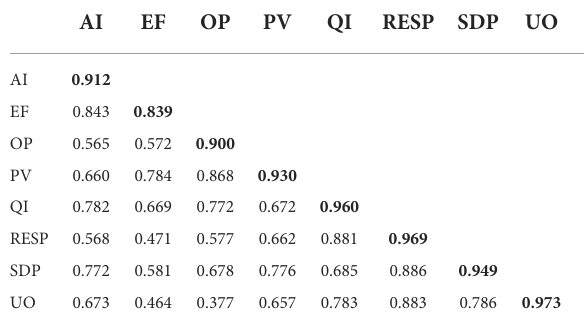
TABLE 4 Discriminate validity.